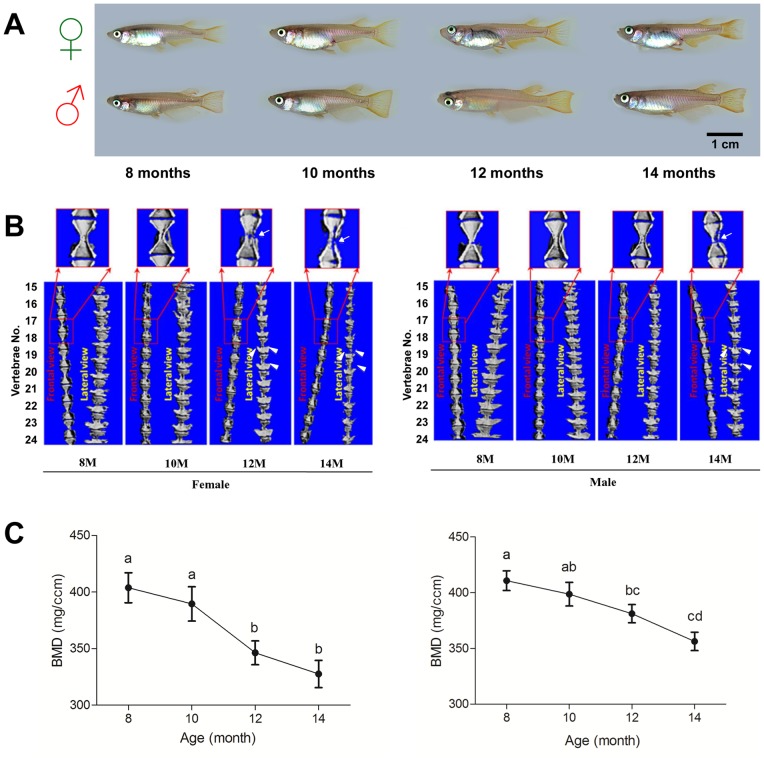
Representative appearance of female (top) and male (bottom) Japanese medaka Oryzias latipes at 8, 10, 12 and 14 months old (Fig. A).(B) Representative micro-architecture of vertebrae bodies at 8, 10, 12 and 14 months in females (left) and males (right) by 3-dimensional microCT reconstruction. (C) Age-related changes in bone mineral density (BMD) from 8 to 14 months in females (left) and males (right) by microCT analysis. White arrows and arrowheads indicate micro-cracks and thinner arches found in 10–14 months old fish. BMD values labeled by the same letter (a, b, c, d) on the graph are not significantly different from each other (p<0.05).